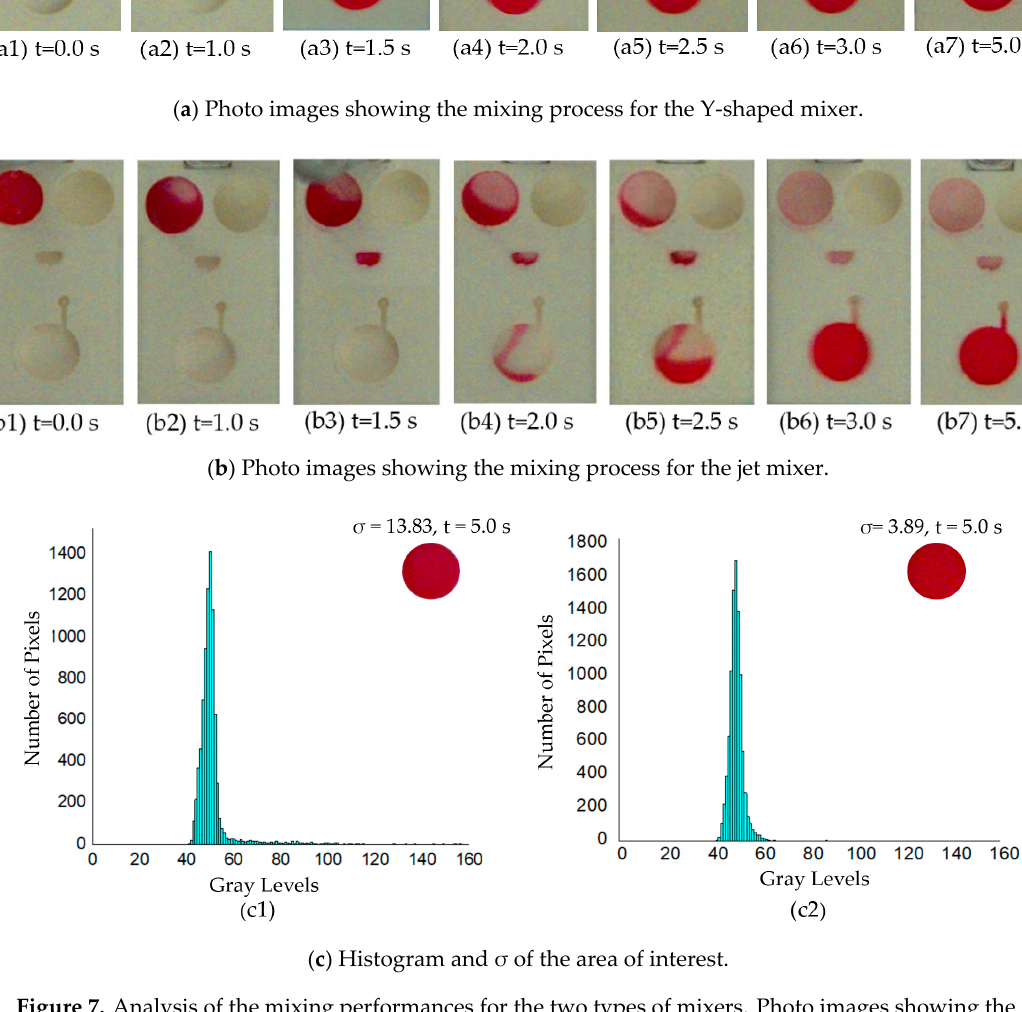
Figure 7. Analysis of the mixing performances for the two types of mixers. Photo images showing the experimental results for ( a ) the Y-shaped and ( b ) the jet mixer; ( c ) histogram and σ of the photo image of the mixed fluid samples for ( c1 ) the Y-shaped mixer and ( c2 ) the jet mixer. Standard deviation ( σ ) is a common method in analyzing mixing performance. Greyscale distribution for the colorless DI water and the red dyed DI water are about from 200–255 and 0–50, respectively. Therefore, experiments were also run using colorless DI water and red dyed DI water to check the mixing efficiencies. The whole experimental process was shown in Figure 7a,b. The mixing process of colorless and red dyed DI water under the observation of a high-speed camera was